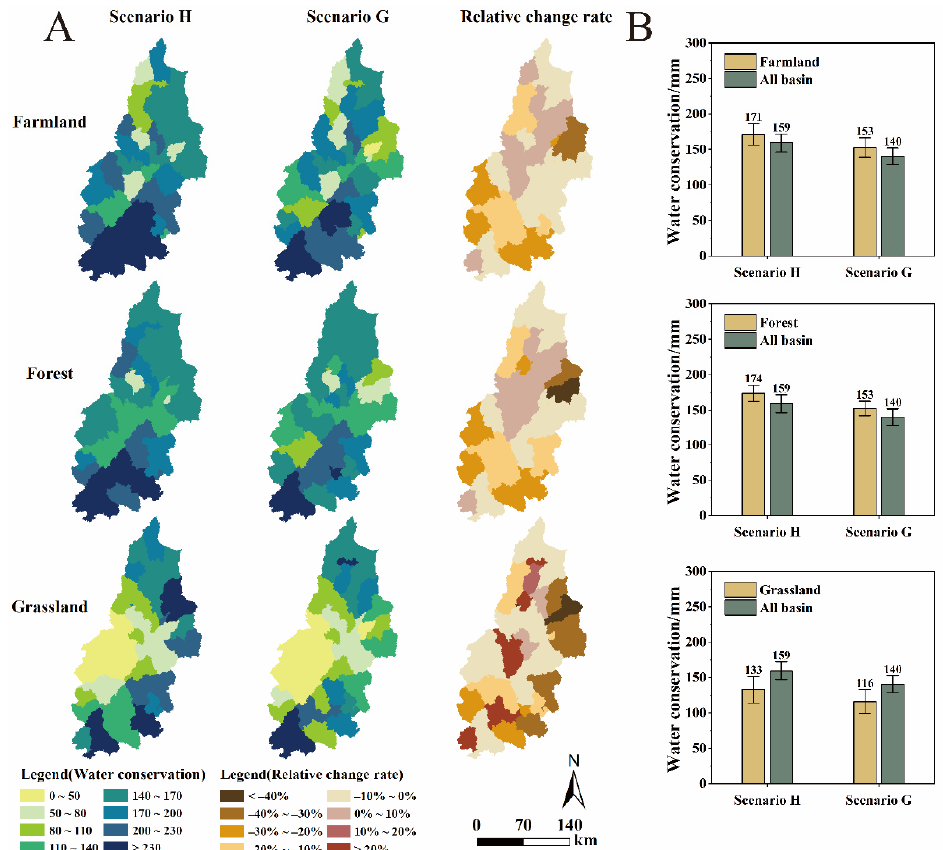
Figure 3. The spatial and temporal distribution of the WCA (mm) in each ecosystem during the wet season ( A ) versus relative changes ( B ).